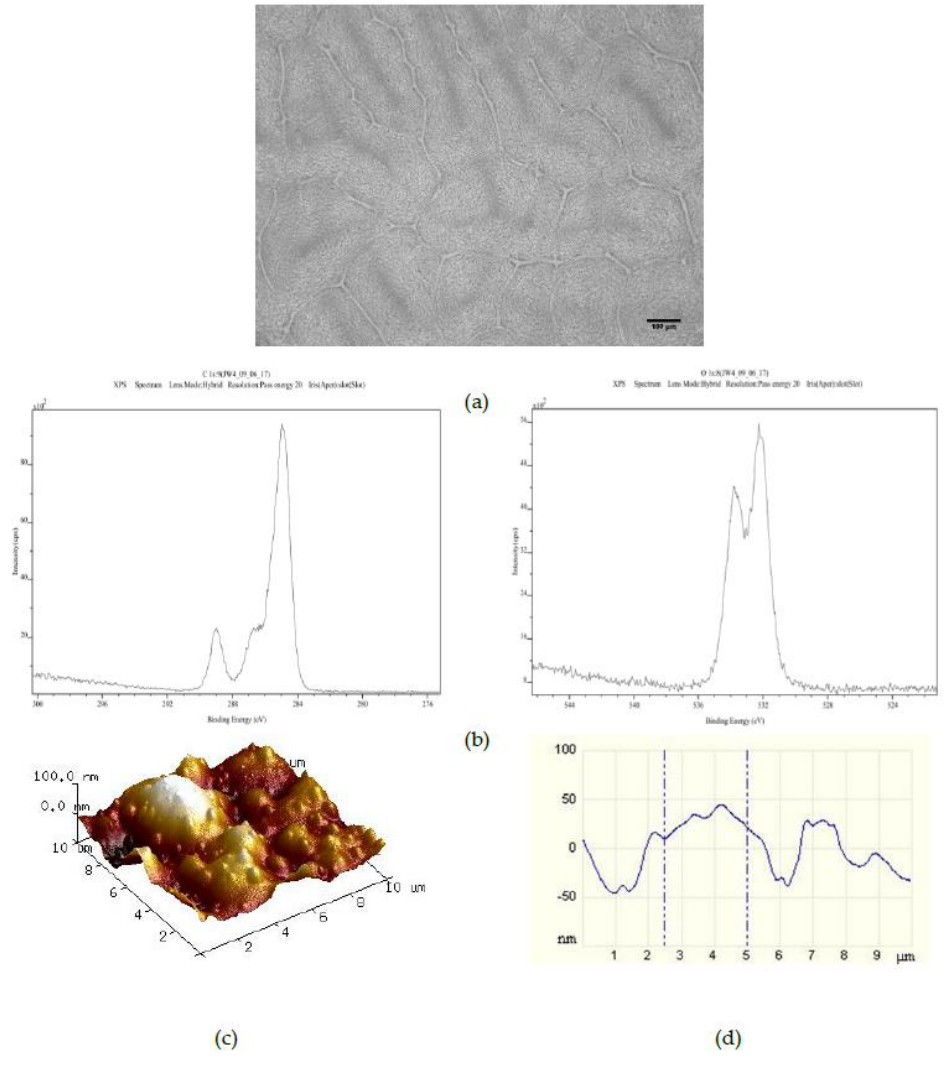
Figure 1. Characterisation of 25PS/75PMMA films by way of ( a ) optical microscopy (×20); ( b ) C1s ( left ) and O1s ( right) XPS spectra; ( c ) AFM 3D image and ( d ) AFM line profile.